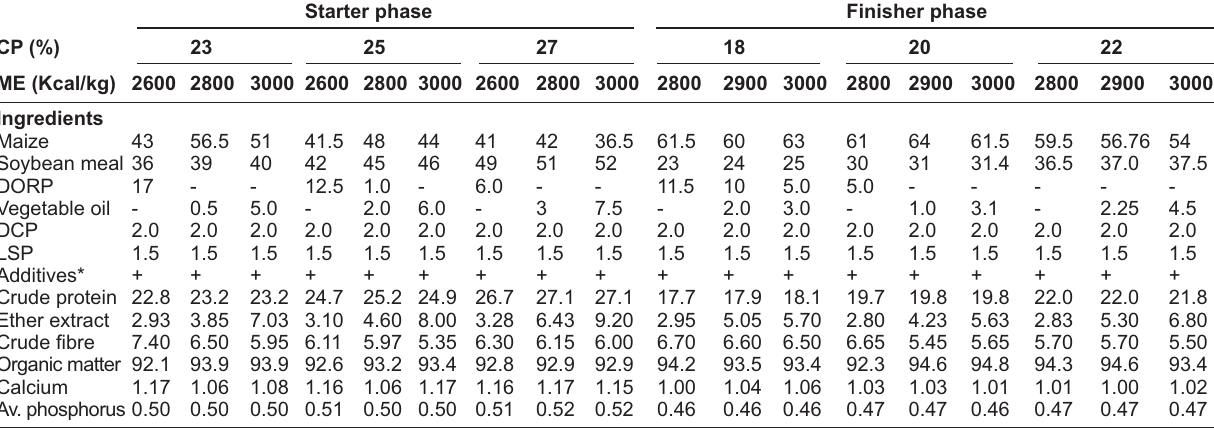
Table-1: Percent composition of experimental starter (1-3 weeks) and finisher (4-5 weeks)